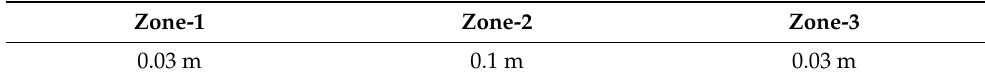
( c ) Figure 10. Overall track plate-soil simulation model. ( a ) Overall model, ( b ) partial view of track plate, ( c ) side view of track plate.